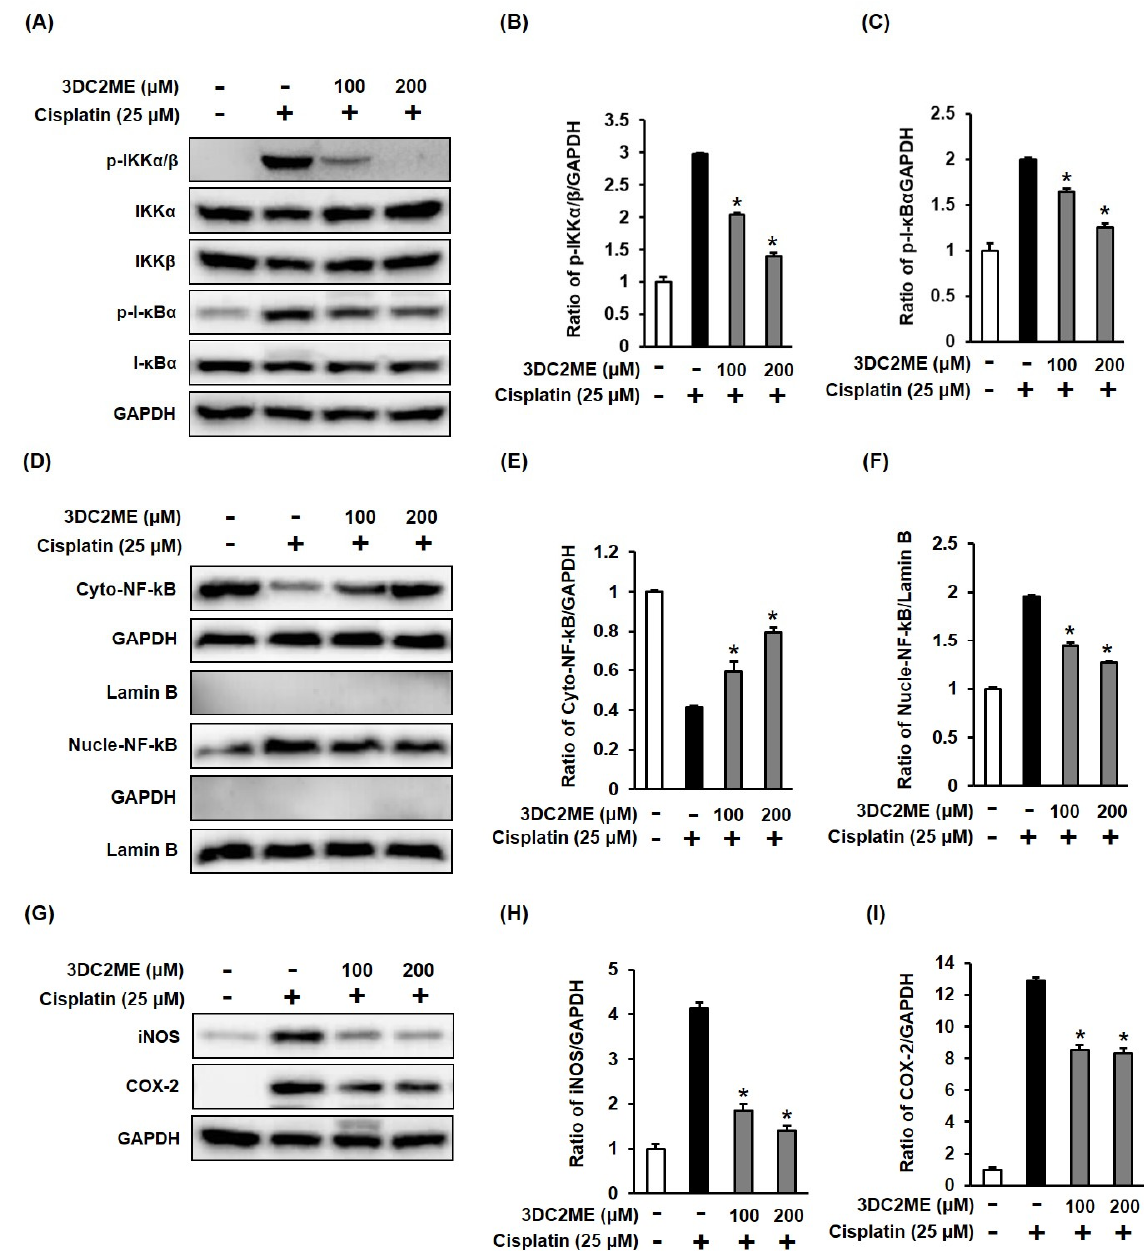
Figure 5. Effects of 3DC2ME and/or cisplatin on the expression of proteins associated with inflammatory pathways in LLC-PK1 cells. ( A ) LLC-PK1 cells were exposed to 25 µ M cisplatin in the presence or absence of 100 or 200 µ M 3DC2ME for 24 h, and western blot analysis was performed using antibodies for phospho-I κ B kinase α / β (p-IKK α / β ), I κ B kinase α (IKK α ), I κ B kinase β (IKK β ), phospho-inhibitor of kappa B alpha (p-I κ B α ), inhibitor of kappa B alpha (I κ B α ), nuclear factor kappa B (NF- κ B), and glyceraldehyde 3-phosphate dehydrogenase (GAPDH). ( B , C ) The ratios of p-IKK α / β and p-I- κ B α compared with the control cells are represented as bar graphs. ( D ) LLC-PK1 cells were exposed to 25 µ M cisplatin in the presence or absence of 100 or 200 µ M 3DC2ME for 24 h, and western blot analysis was performed using antibodies for NF-kB, lamin B, and GAPDH. ( E , F ) The ratios of nuclear NF-kB and cytosolic NF-kB compared with the control cells are represented as bar graphs. ( G ) LLC-PK1 cells were exposed to 25 µ M cisplatin in the presence or absence of 100 or 200 µ M 3DC2ME for 24 h, and western blot analysis was performed using antibodies for inducible nitric oxide synthase (iNOS), cyclooxygenase-2 (COX-2), and GAPDH. ( H , I ) The ratios of iNOS and COX-2 compared with the control cells are represented as bar graphs (mean ± SD, * p < 0.05 cisplatin-treated LLC-PK1 cells).